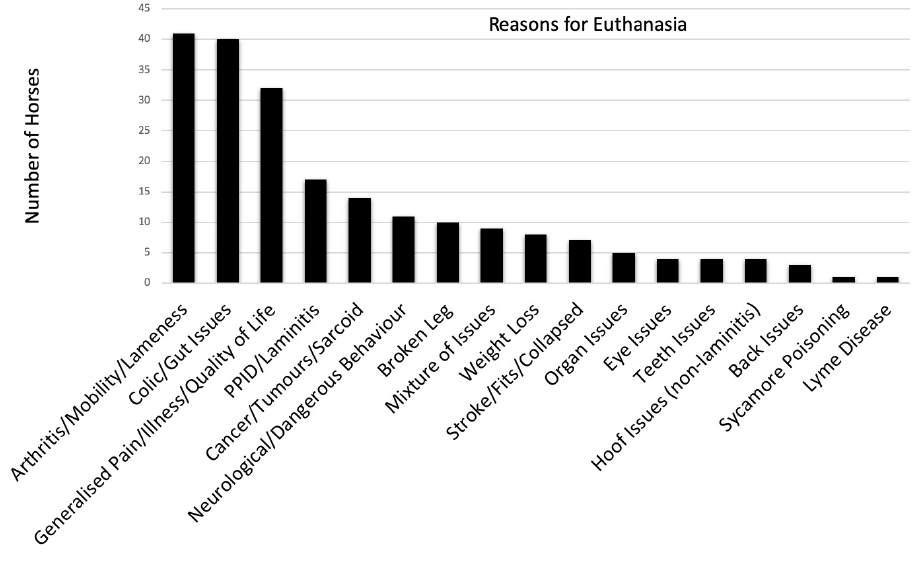
Figure 2. Responses to the free-text question regarding reasons for euthansia. The majority of the 211 horses discussed were euthanised for predominently physical reasons linked to “Freedom from pain, illness and disease”, with the exception of the 11 horses euthanised for dangerous behaviour (which may well have been linked to undiagnosed pain nonetheless [9]). A small number of respondents included additional considerations of mental health and other “freedoms” in their decision, as discussed in the text. Table 5. Characteristics of the factors identified using PCA. “Label” refers to the names we gave each factor, “Freedom From/To...” lists the Freedoms relevant to the scenarios loaded on each factor and “Attitude Towards Likelihood of Euthanasia” reflects the most common Likert responses, as listed in Table